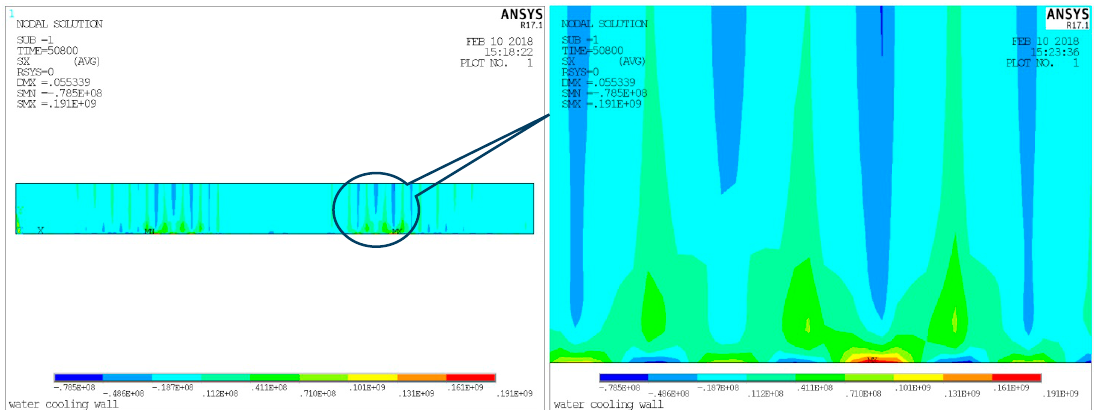
Figure 13. Thermal stress distributions along the width of the front wall at the highest tube temperature difference.